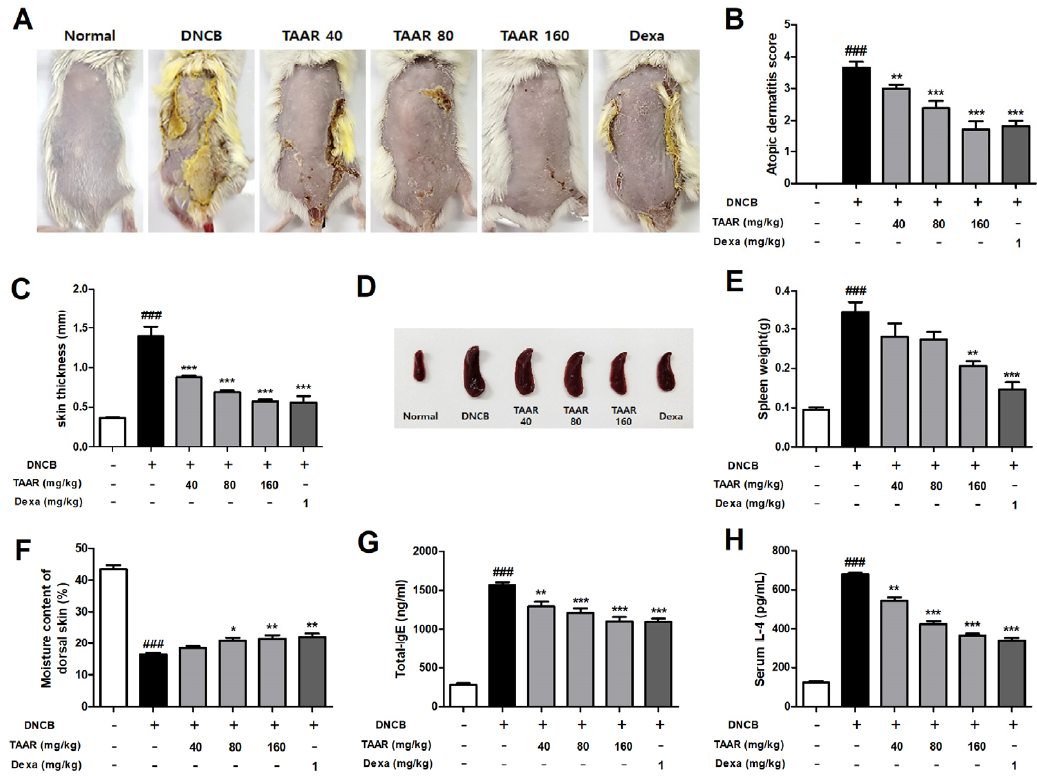
Figure 6. Effect of TAAR extract on DNCB-induced AD-like clinical symptoms in mice. ( A ) Represen- tative photographic images of AD-like dorsal skin lesions from mice from each group. ( B ) Atopic dermatitis score and ( C ) skin thickness. ( D ) Representative photographs of mouse spleen and ( E ) spleen weight of mice from each group. ( F ) Moisture content of dorsal skin. ( G ) Total serum IgE and ( H ) serum IL-4 levels. All values are presented as the mean ± SEM of three experiments. Data were analyzed by Tukey’s post hoc test. ### p < 0.001 vs. normal control group; * p < 0.05, ** p < 0.01, and *** p < 0.001 vs. DNCB-treated only